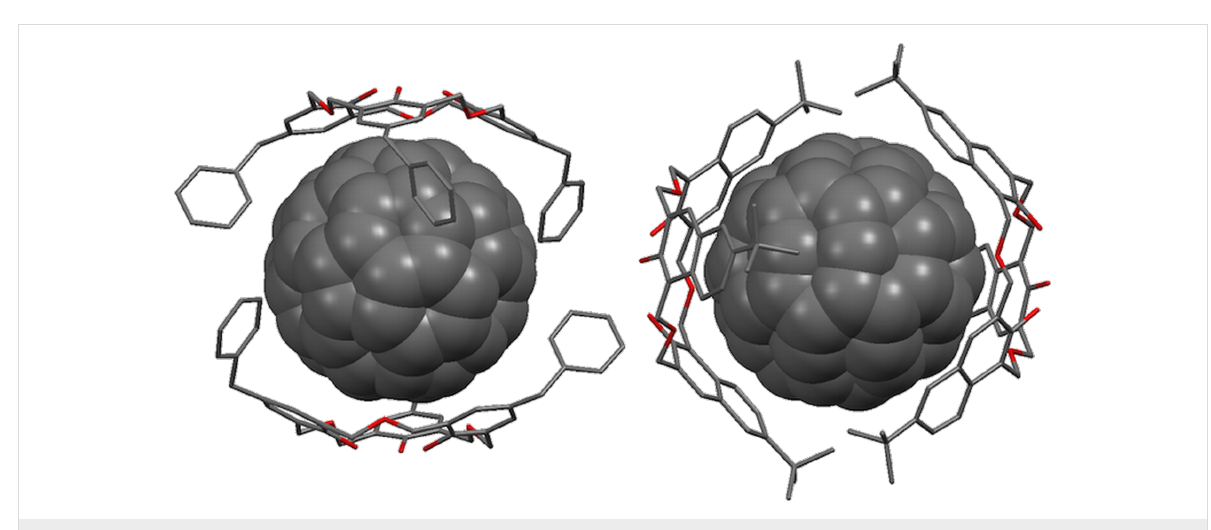
Figure 25: X-Ray crystal structure of 3i and 6a encapsulating C 60 (CCDC ID 102473 and 166077)